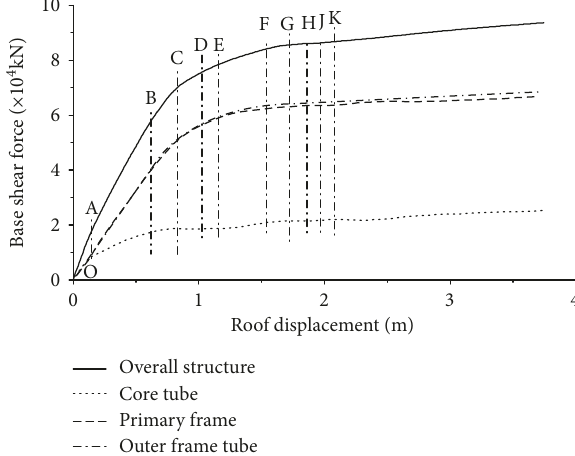
Figure 6: Pushover curves of model 5MBC contained the following details: overall structure, core tube, primary frame, and outer frame